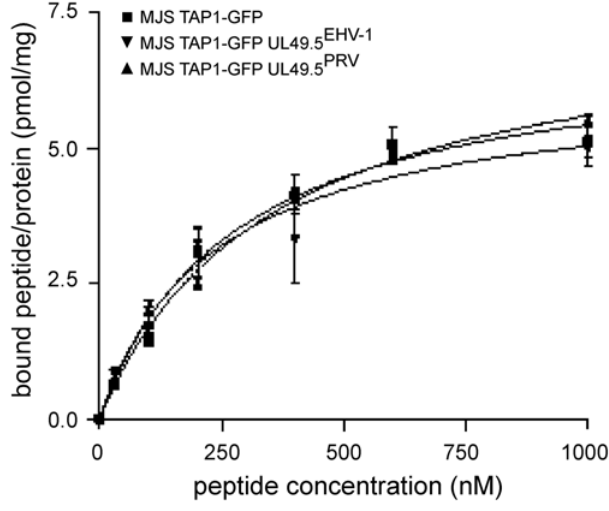
Figure 7. UL49.5 of PRV and EHV-1 do not interfere with peptide binding to TAP. To evaluate peptide binding to the TAP complex, microsomal membranes from MJS TAP1-GFP cells (control; & ), or MJS TAP1-GFP cells expressing UL49.5 of PRV ( m ) or EHV-1 ( . ) were incubated with increasing concentrations of the radiolabeled peptide (RR[ 125 I]YQK- STEL). Unspecific binding was determined in the presence of 200-fold excess of ICP47 (data not shown). The amount of specifically bound peptide per amount of microsomal protein is plotted against the peptide concentration. K d values for control MJS: 277 6 58 nM, for MJS UL49.5 PRV : 351 6 42 nM and for MJS UL49.5 EHV-1 : 236 6 71